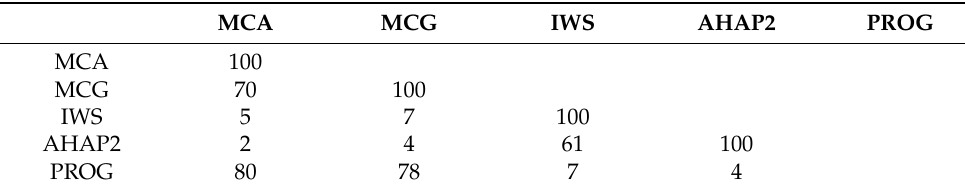
Table 1. The degree of overlap, i.e., the number of animals selected in common, between the MCA, MCG, IWS, AHAP2, and PROG A methods. The number of animals sampled by each method is displayed on the diagonal.